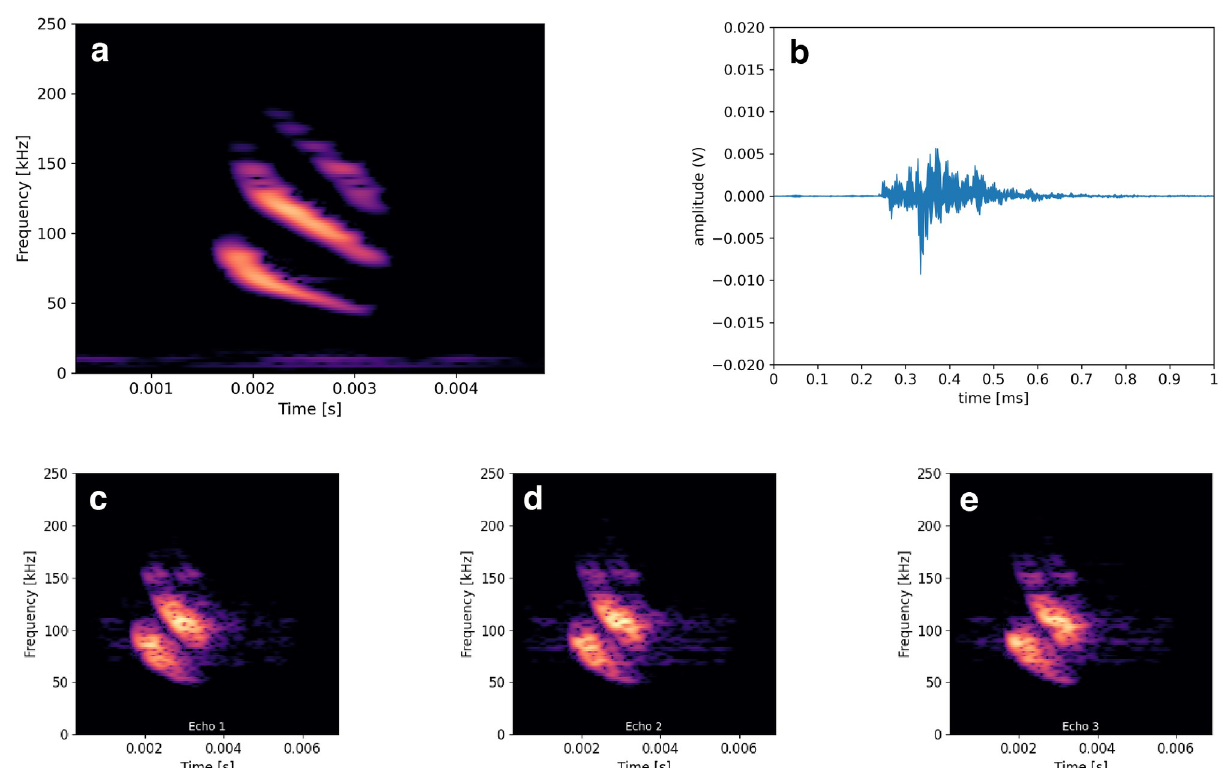
Fig 7. Example spectrograms used as input to the convolutional neural network. ( a ) Echolocation call from Pallas’s long-tongued bat ( Glossophaga soricina ). ( b ) Example impulse response of a flower recording. ( c-e ) Example spectrogram sequence used as input.